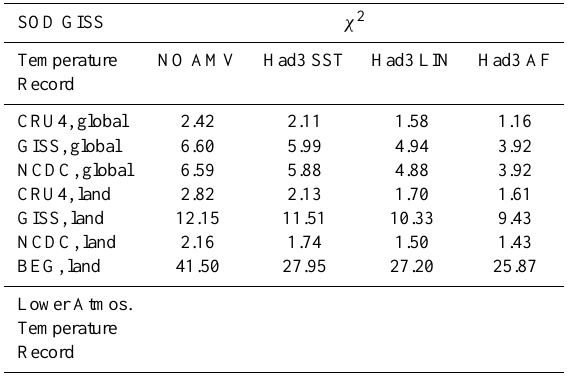
Table 2. Values of reduced chi-squared (Eq. 7) calculated for all model